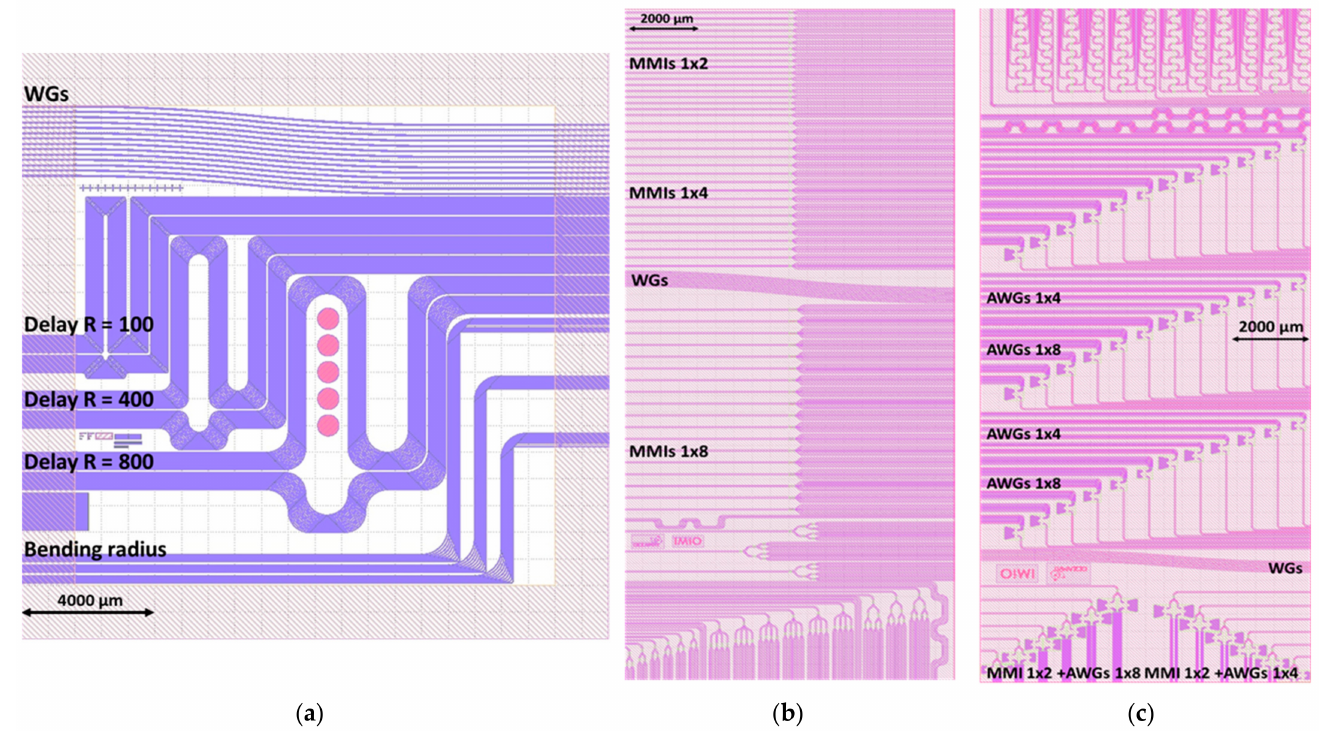
Figure 8. Comparison of layouts: ( a ) Layout 1; ( b ) Layout 2; ( c ) Layout